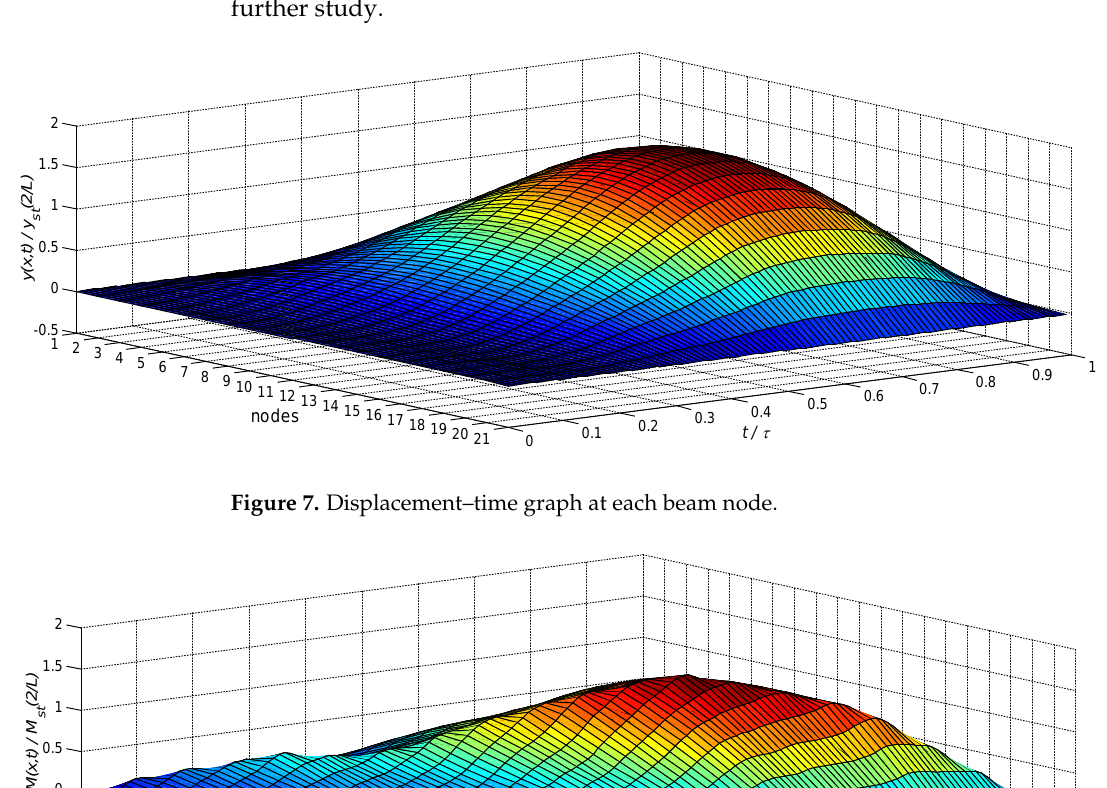
Figure 6. Dynamic magnification factors of the beam under moving load P at different speeds.